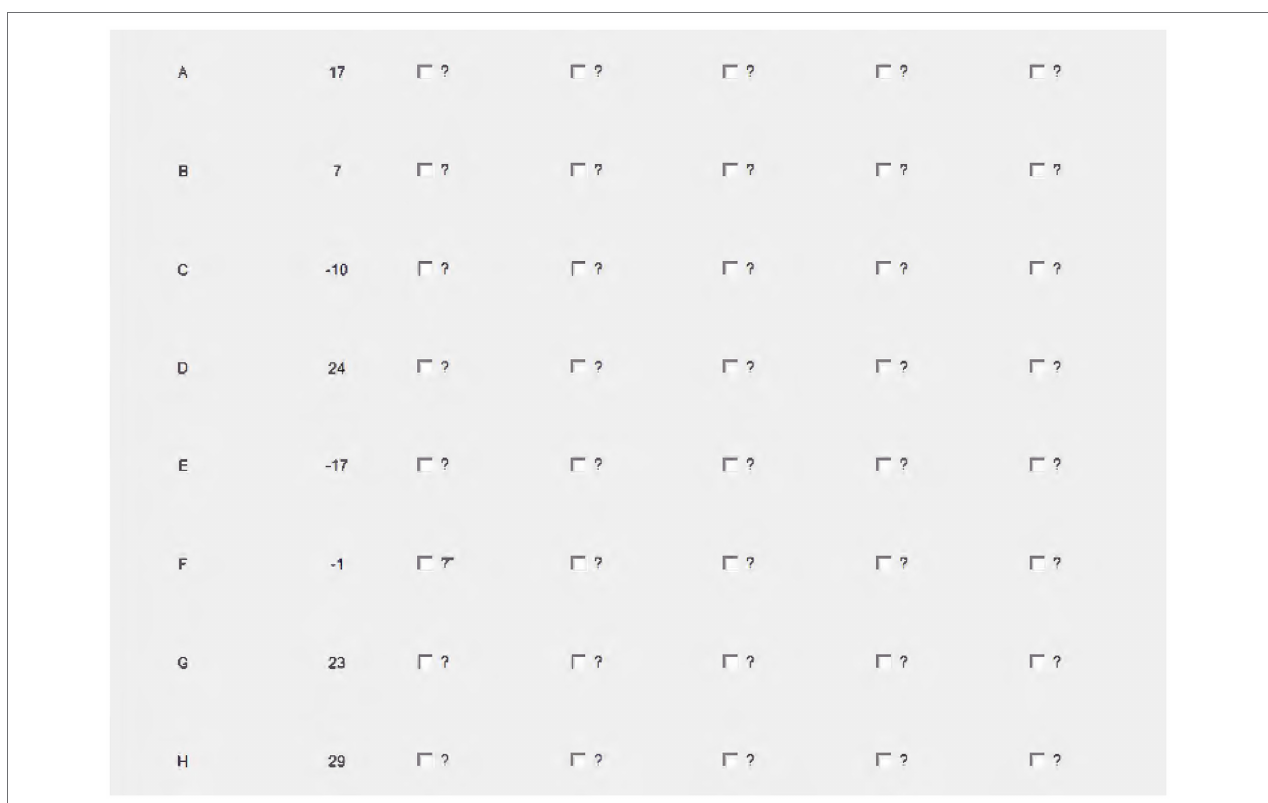
FIGURE 1 | Selection game of N